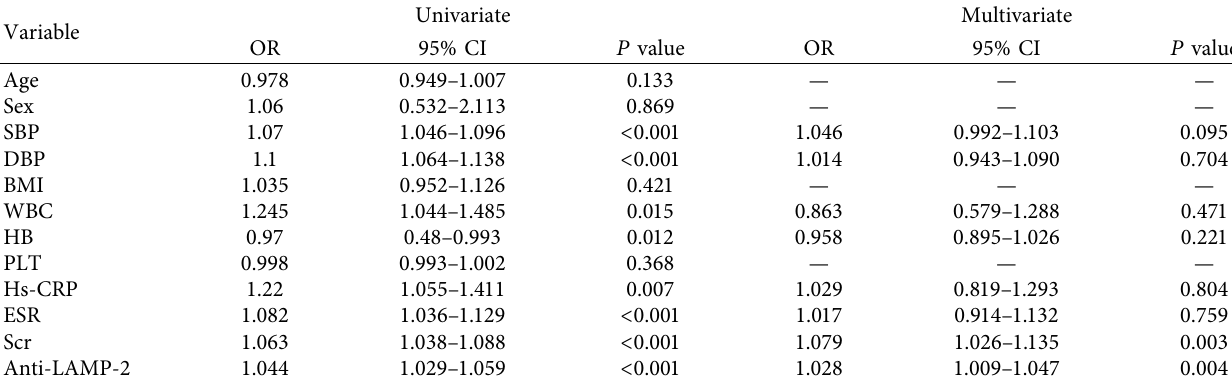
Table 3: Logistic regression analysis of vasculitis combined with hypertension patients versus controls.